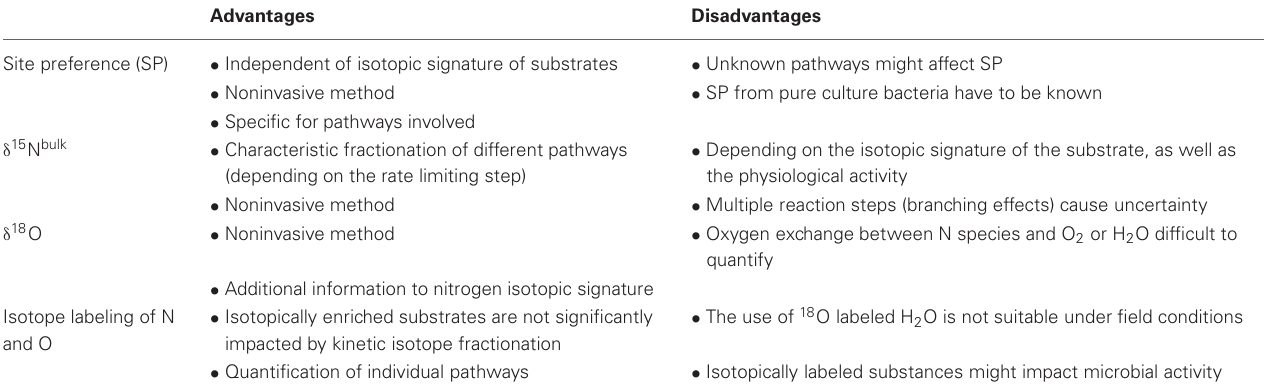
Table 3 | Advantages and disadvantages of SP, δ 15 N bulk , and δ 18 O, on a natural abundance or labeled level [adapted from Baggs (2008)]. Advantages